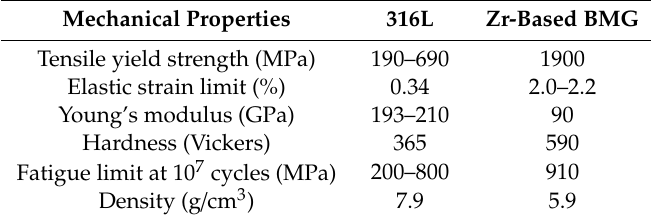
Table 2. Comparison of two common biomaterials in terms of mechanical properties [25].